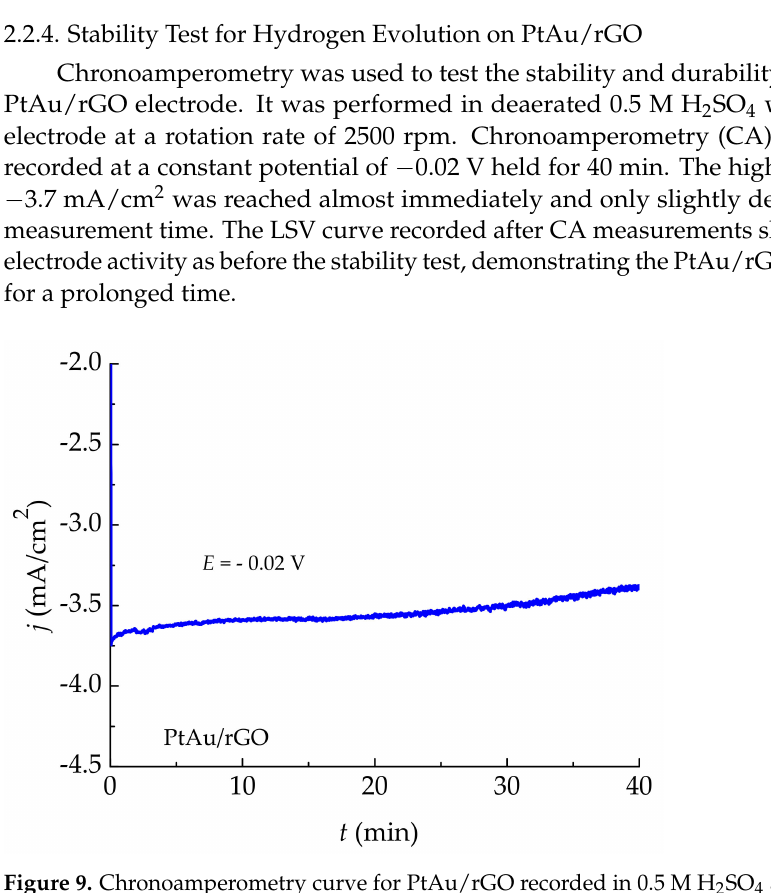
Figure 9. Chronoamperometry curve for PtAu/rGO recorded in 0.5 M H 2 SO 4 at a constant potential of − 0.02